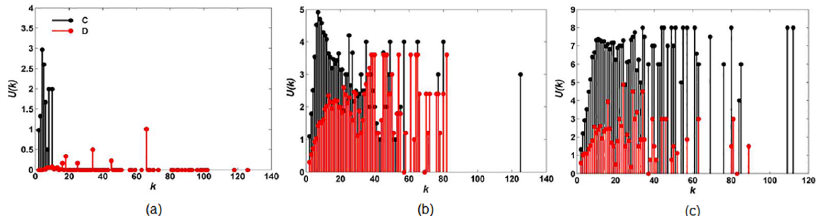
Fig 8. Average payoff U ( k ) of a player of degree k in the stationary regime of evolutionary dynamics under (a) W = 4, b = 1.01, (b) W = 6, b = 1.2 and (c) W = 8, b = 1.3. Cooperator is denotedby C with black and defector by D with